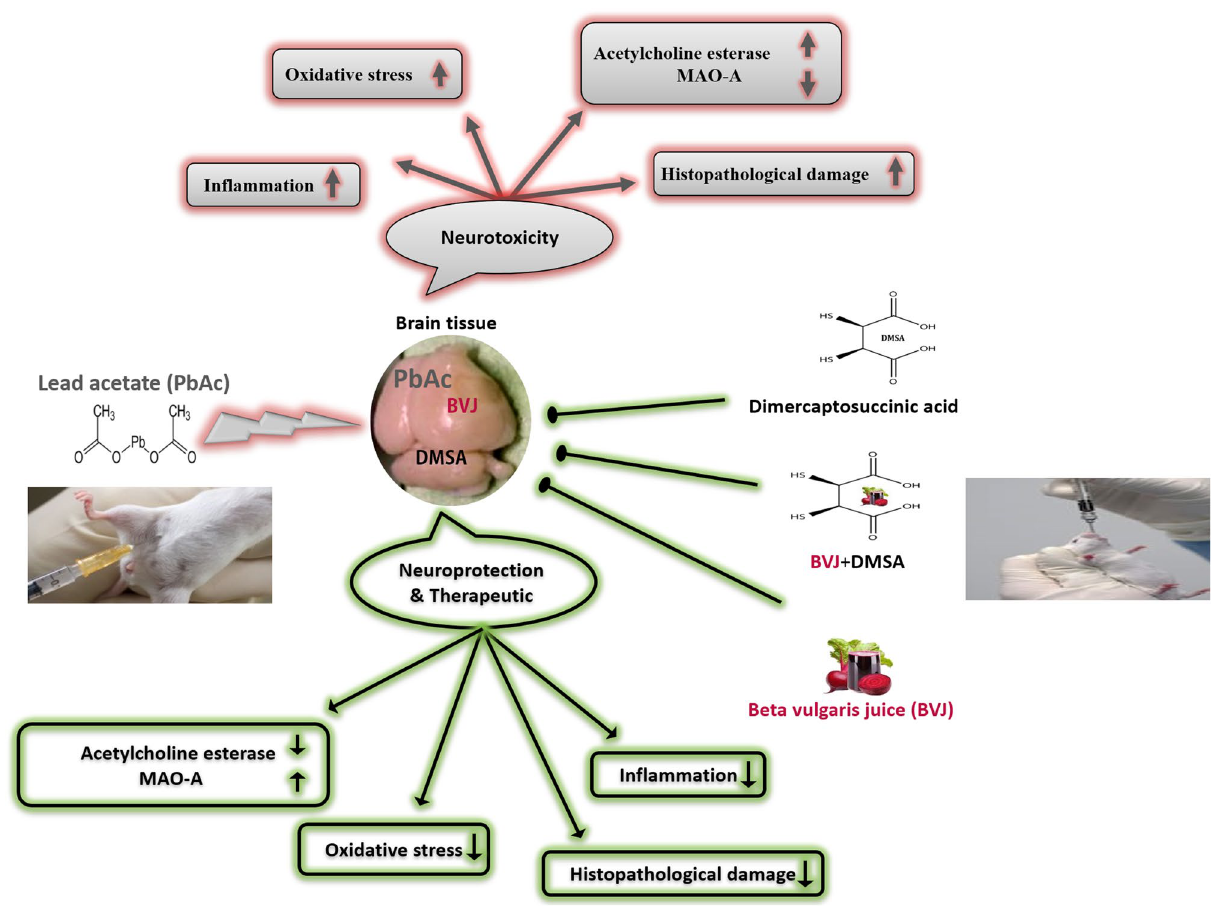
Figure 7. Graphical